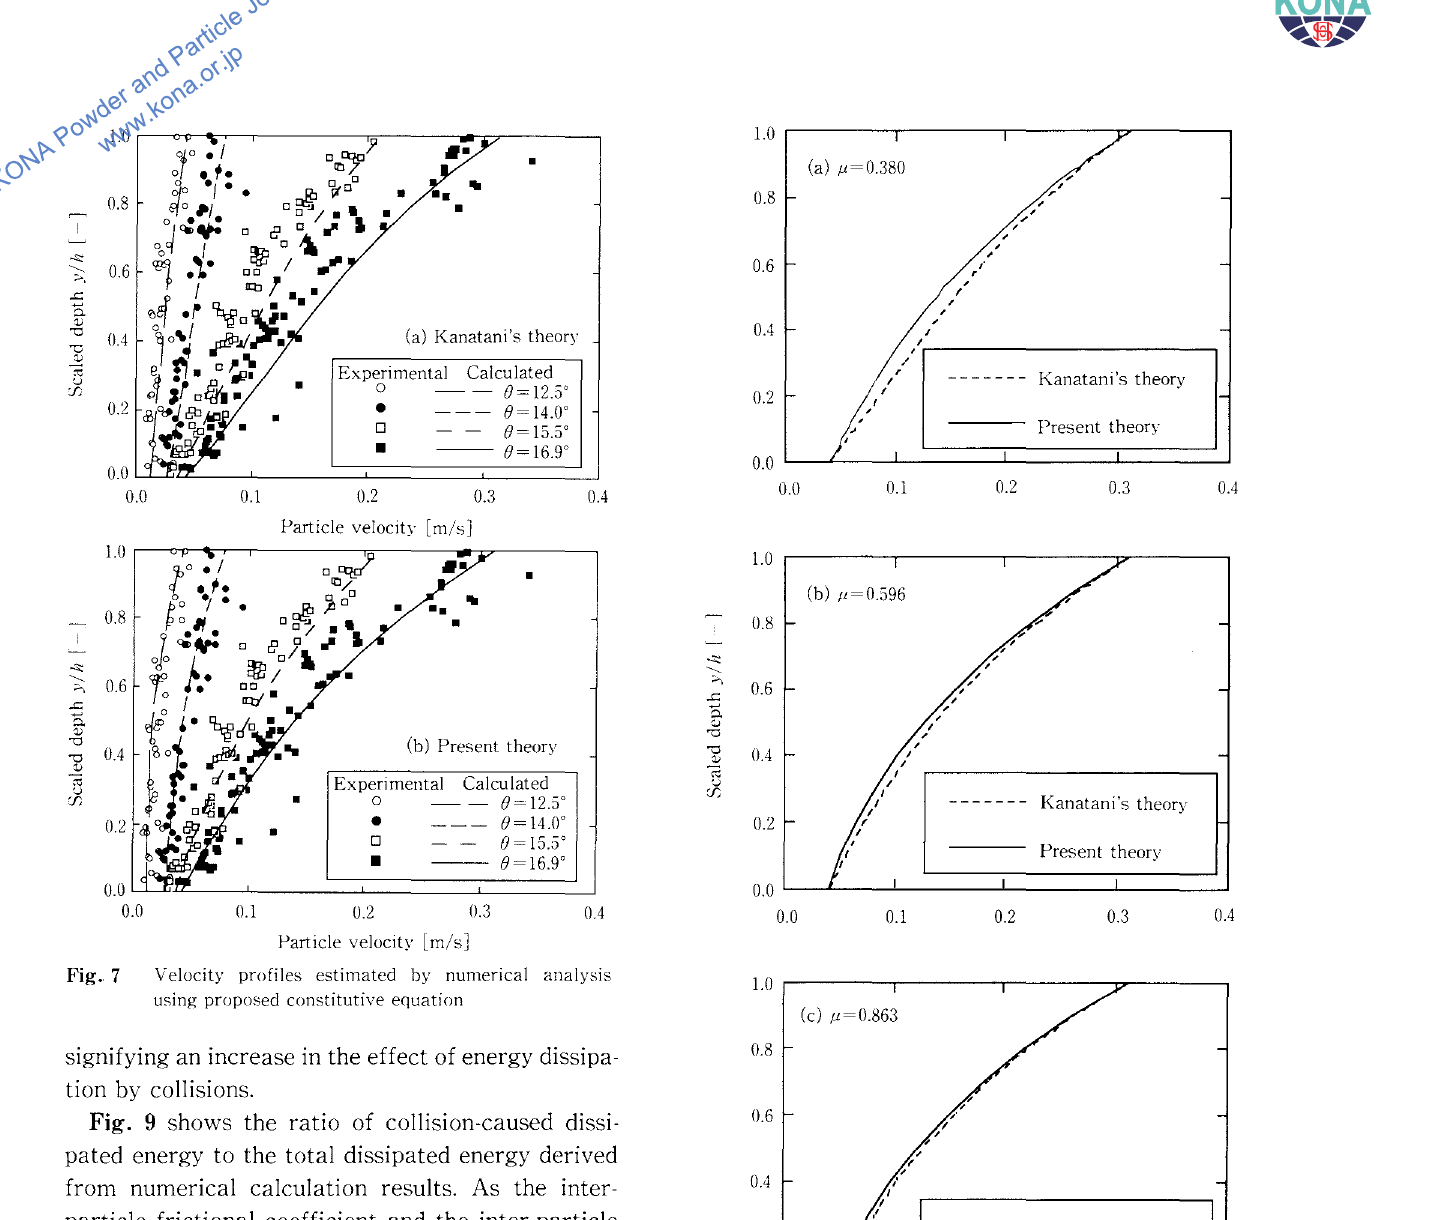
Velocity profiles estimated by numerical analysis using proposed constitutive equation signifying an increase in the effect of energy dissipa tion by collisions.